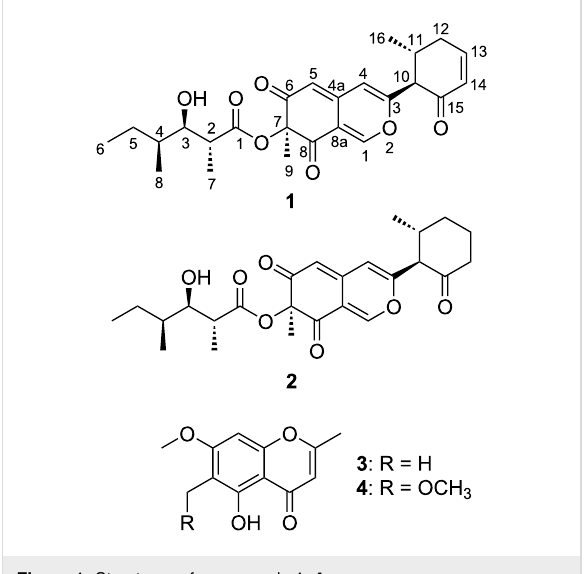
Figure 1: Structures of compounds 1 – 4 .